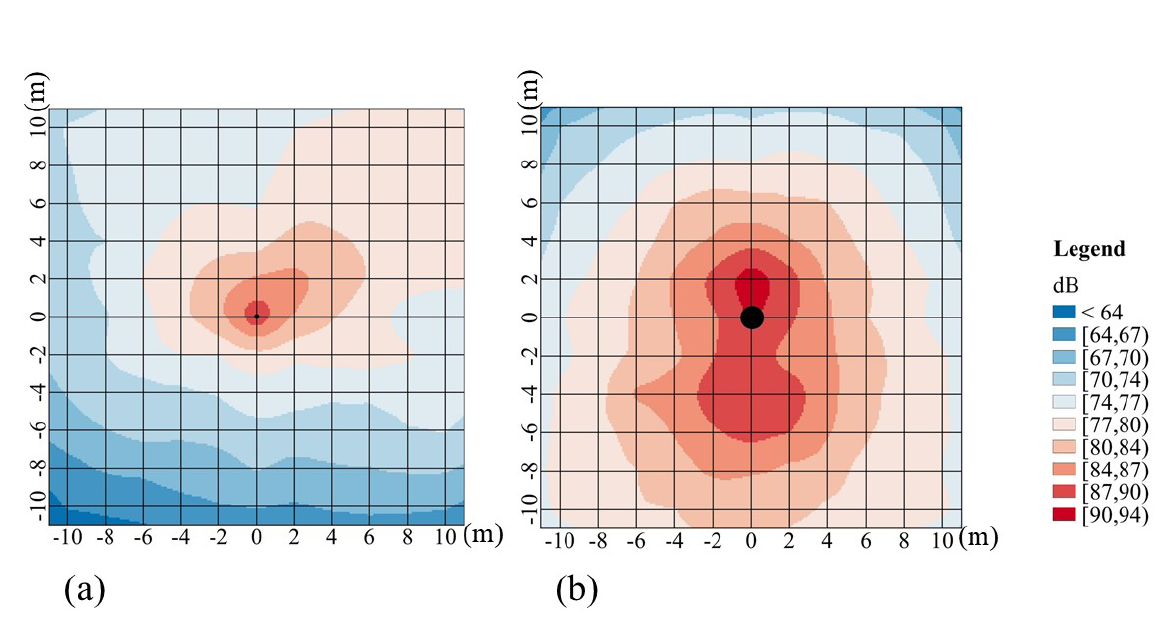
Figure 3. Map of the spatial distribution of noise emitted by the tractor. (a) without activation of a rotary cutter (b) with activation of a rotary